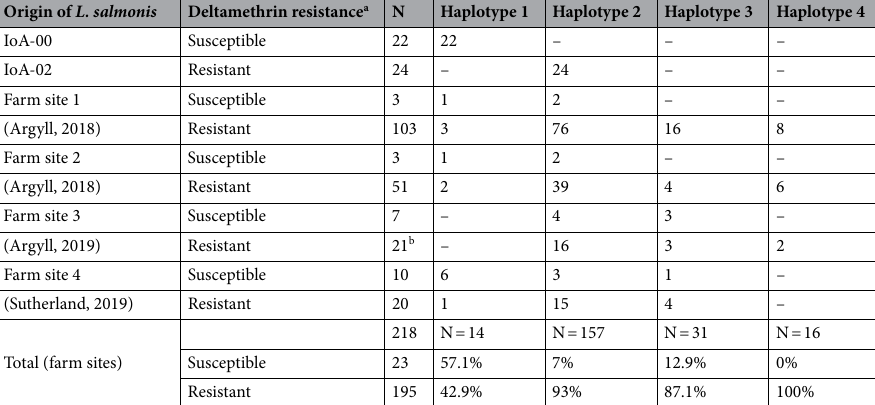
Table 2. Association of mitochondrial haplotypes with deltamethrin resistance. L. salmonis of laboratory strains IoA-00 and IoA-02 and parasites obtained from Scottish aquaculture production sites were subjected to deltamethrin bioassays to establish susceptibility status, followed by genotyping at four SNP loci to establish haplotypes (see Table 1 for details). a Susceptibility to deltamethrin was determined in single-dose bioassays, involving exposure (30 min) to 2 µg/L deltamethrin, followed by recovery in seawater (24 h) and subsequent rating as susceptible (affected) or resistant (unaffected). b 21 out of a total of 37 deltamethrin resistant individuals observed were successfully